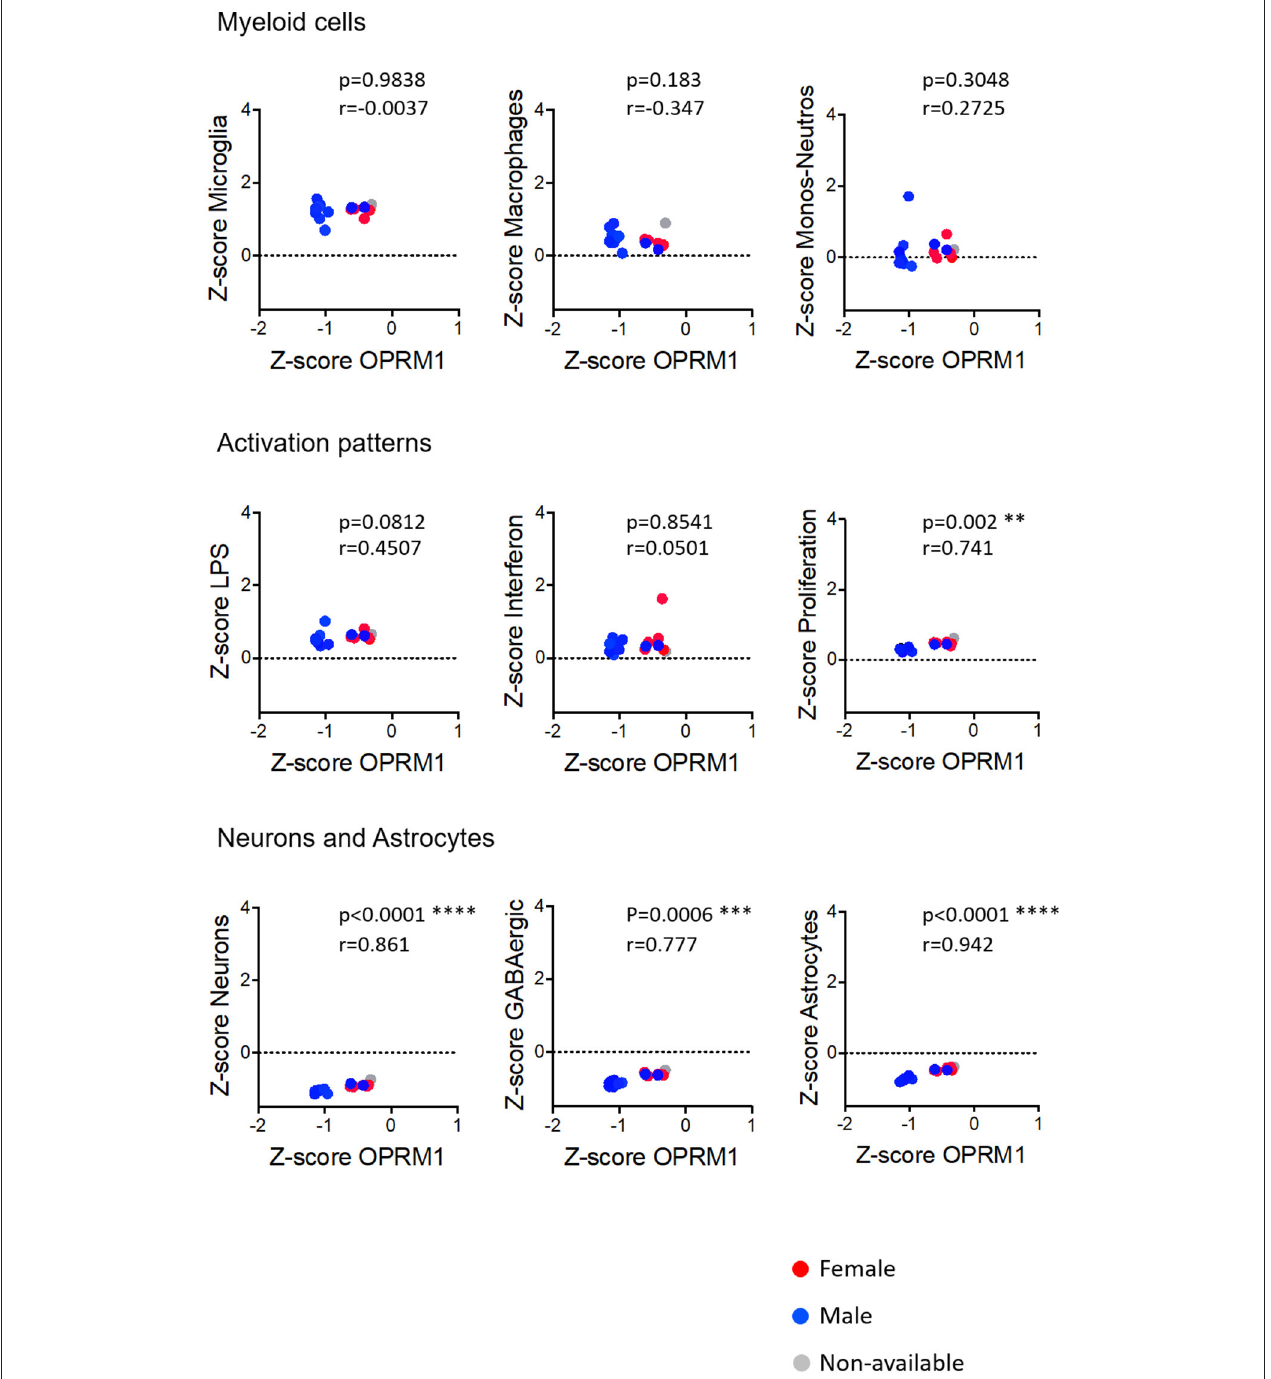
FIGURE 9 | Correlation of Oprm1 gene expression within the Myeloid cells, Activation patterns and Neurons and Astrocytes gene clusters in human cortex datasets. Oprm1 expression had a negative correlation with Microglia- and Macrophage-related genes ( r < 0) and a positive correlation with the Monocytes-Neutrophils-related genes which were not statistically significant ( p > 0.05; ns). Within the Activation patterns-related genes, Oprm1 expression has a weak positive correlation ( r < 0.5) which is not statistically significant for the LPS-related genes ( p > 0.5). There is a statistically significant positive correlation between Oprm1 expression and the Proliferation-related genes ( r = 0.741 ; ** p = 0.002). There is a statistically significant positive correlation between Oprm1 expression and the GABAergic- ( r > 0.5 ; *** p = 0.0006), Neurons-, and Astrocytes-related genes ( r > 0.5 ; **** p < 0.0001).